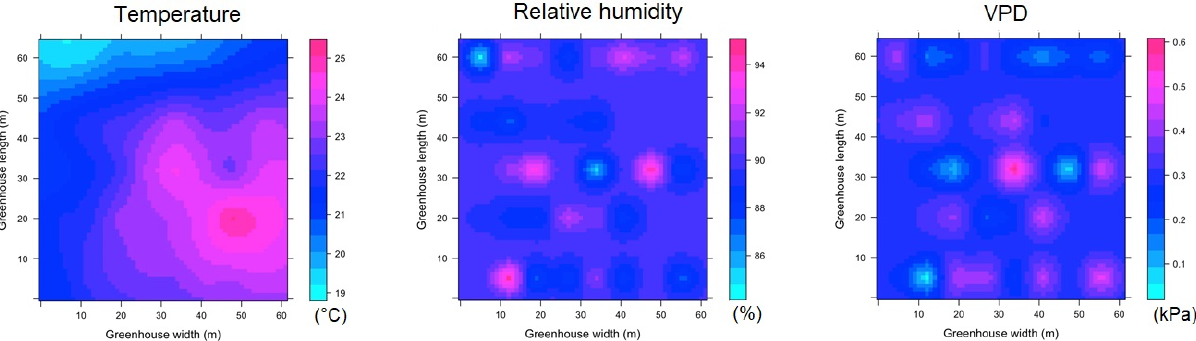
Figure 10. Spatial distribution predicted by kriging, for temperature, relative humidity and VPD in TG and for ESRL 5.